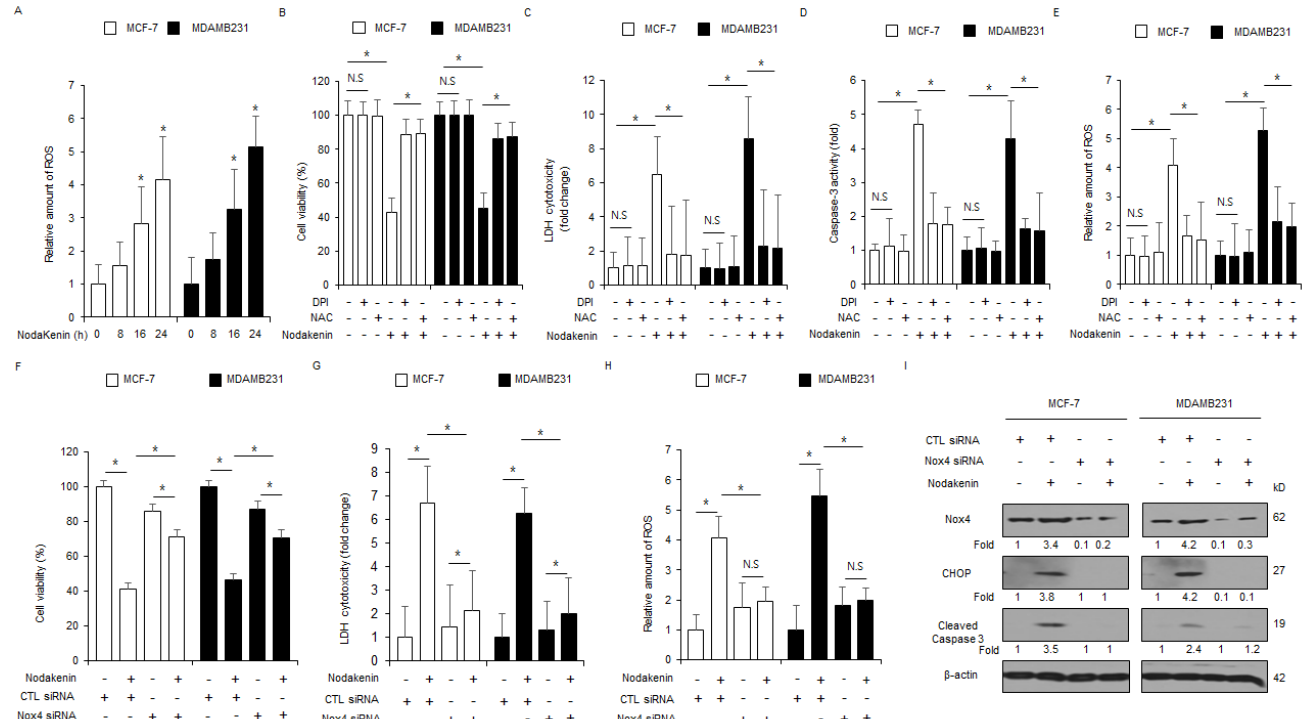
Figure 7. Inhibition of Nox4 suppresses nodakenin-mediated ROS production and ER stress in breast cancer. ( A ) ROS experiment by DCFDA dye performed with FACS analysis in nodakenin (40 μM, 24 h)-treated MCF-7 and MDAMB231 cells; * p < 0.05. ( B – E ) MCF-7 and MDAMB231 cells were treated with nodakenin (40 μΜ , 24 h), NAC (100 μM, 24 h), and DPI (1 μM, 24 h). Then LDH cytotoxicity, WST-1, ROS, and caspase-3 activity assays were performed; * p < 0.05. n.s., not significant. ( F – I ) MCF-7 and MDAMB231 cells were transfected with Nox4 siRNAs and treated with nodakenin (40 μM, 24 h). WST-1, LDH cytotoxicity, and intracellular ROS assays were performed along with Western blot analyses for CHOP, Nox4, and cleaved caspase-3; * p < 0.05. n.s., not significant. Western blot analyses were confirmed in at least three independent experiments.